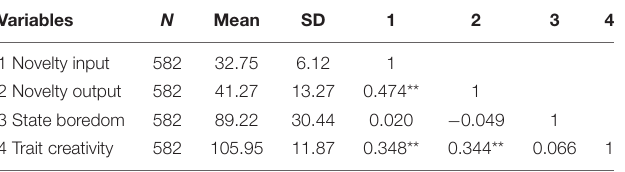
TABLE 1 | Descriptive statistics and results of correlational analysis.